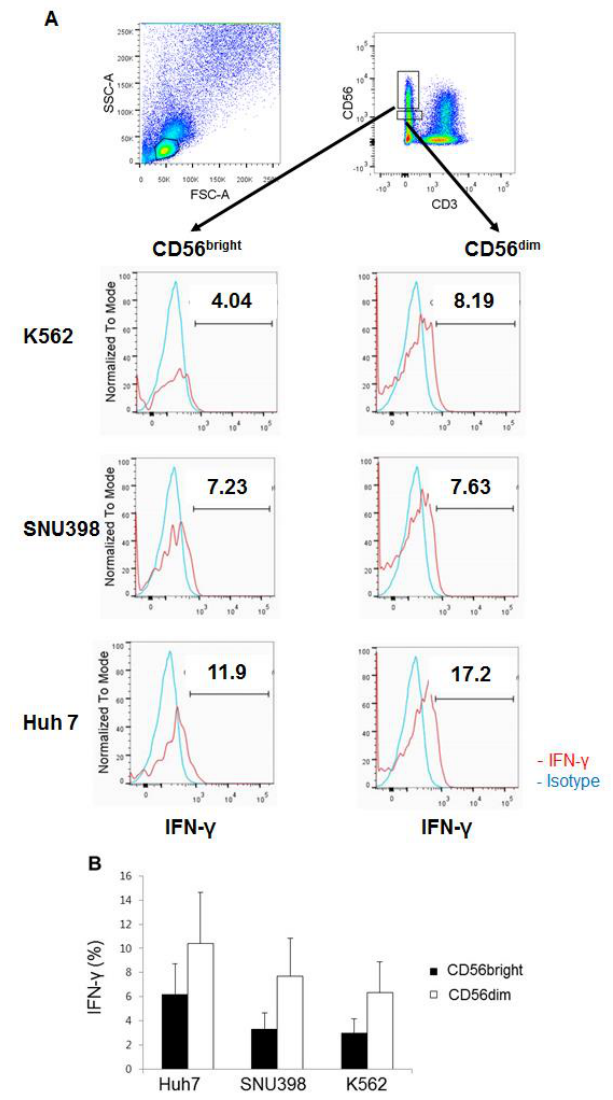
Figure 6. Robust production of IFN-γ by CD56 dim HI NK cells in response to Huh7 cells. ( A ) Representative plots of four independent experiments are shown. Live lymphocytes are gated by FSC/SSC. ( B ) The summarizing graph shows the means ± SEM of IFN-γ + HI NK cells. n = 4.